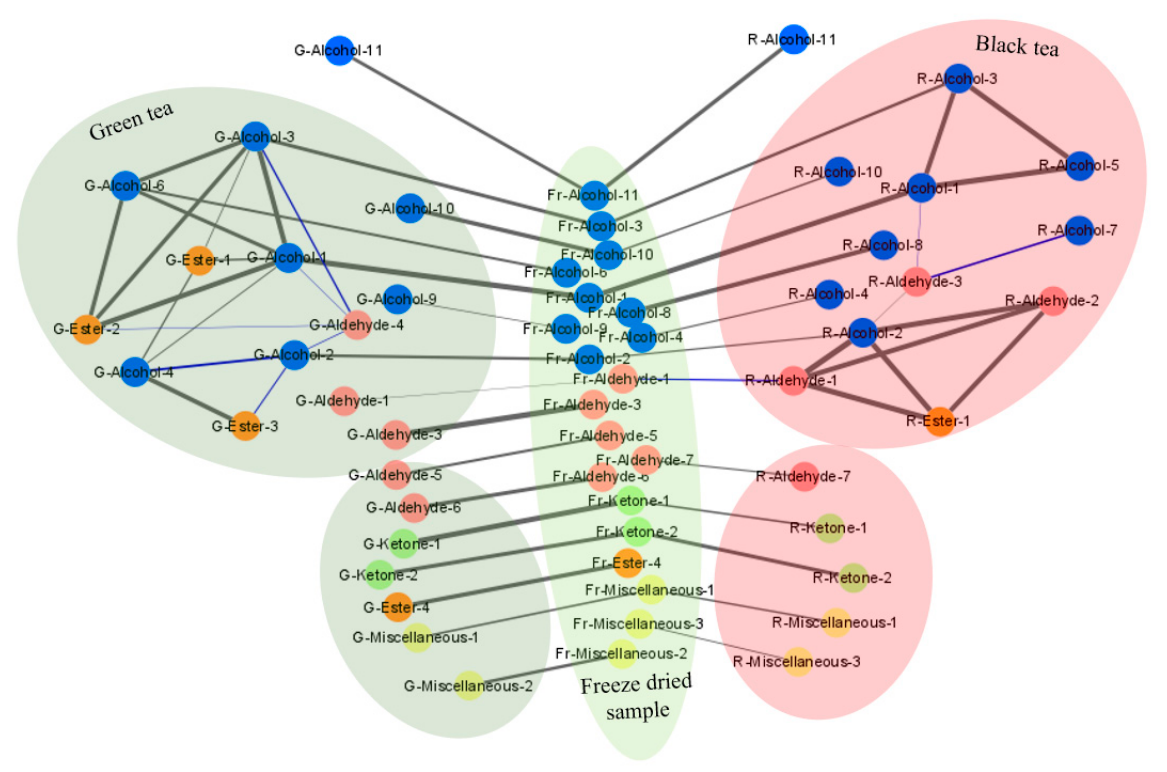
Figure 6. Correlation network of the top ten volatiles in green tea and black tea correlated with the shared volatiles in three types of tea samples. Alcohol compounds (blue nodes), aldehyde compounds (red nodes), ketone compounds (light green nodes), ester compounds (orange nodes), and miscellaneous compounds (light yellow nodes). The correlation analysis of the contents of the key volatiles in different tea samples was conducted by the Cytoscape software (version 3.8.0) (https://cytoscape.org/, accessed on: 23 March 2021). A significant correlation was presented based on the statistical test with a robust cutoff ( p -value < 0.05), with a black line indicating a positive correlation and a blue line indicating a negative correlation. The absolute value of the correlation coefficient increased from 0.515 to 0.984 as the line width was increased. The number of replicates is equal to 3.